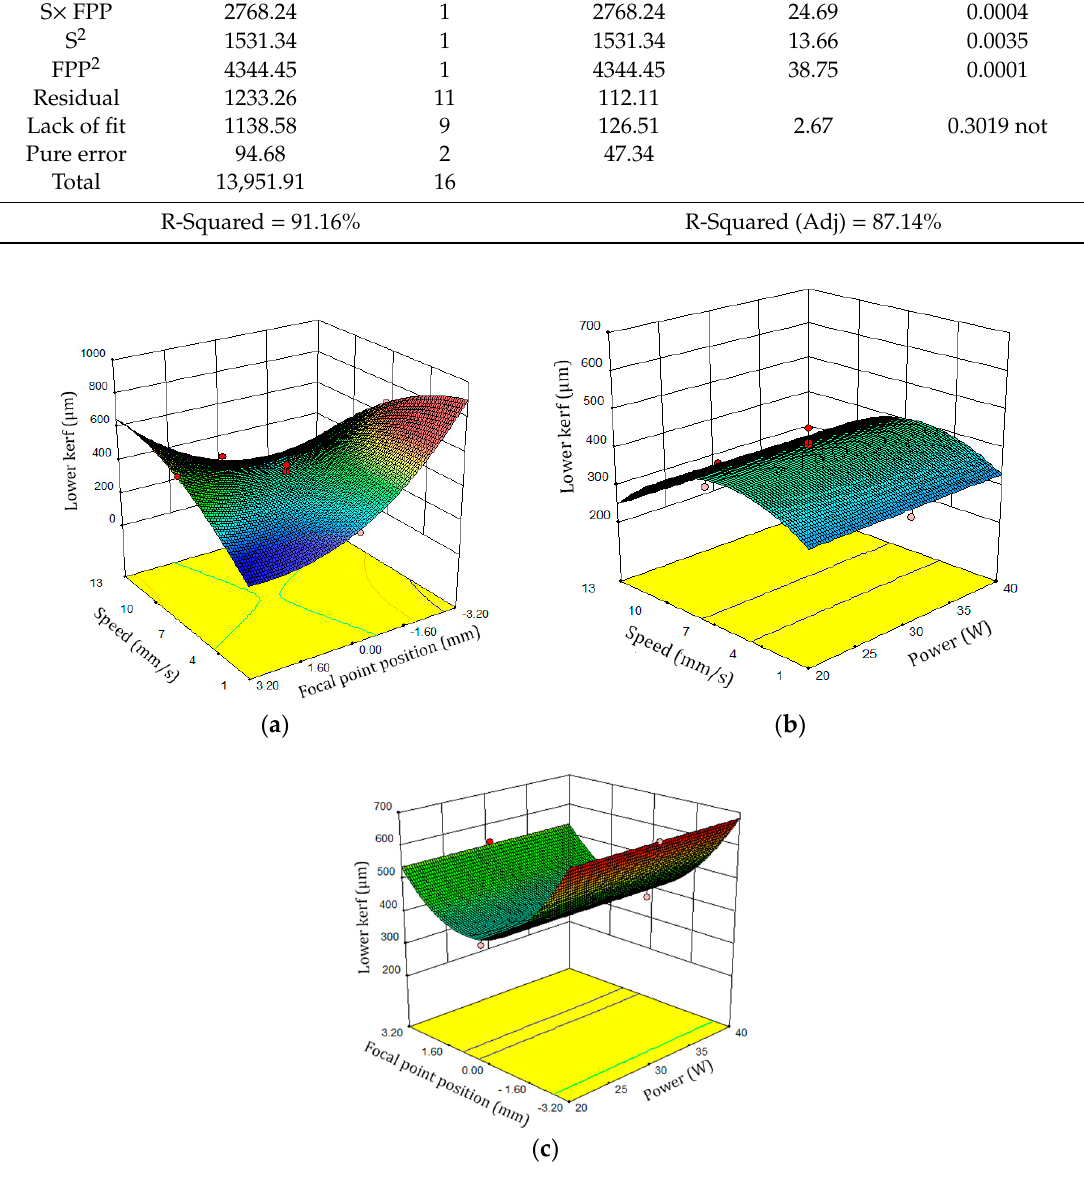
Figure 9. Bottom kerf width surface plot: ( a ) scanning speed and FPP, ( b ) laser power and cutting speed, ( c ) FPP and laser power.